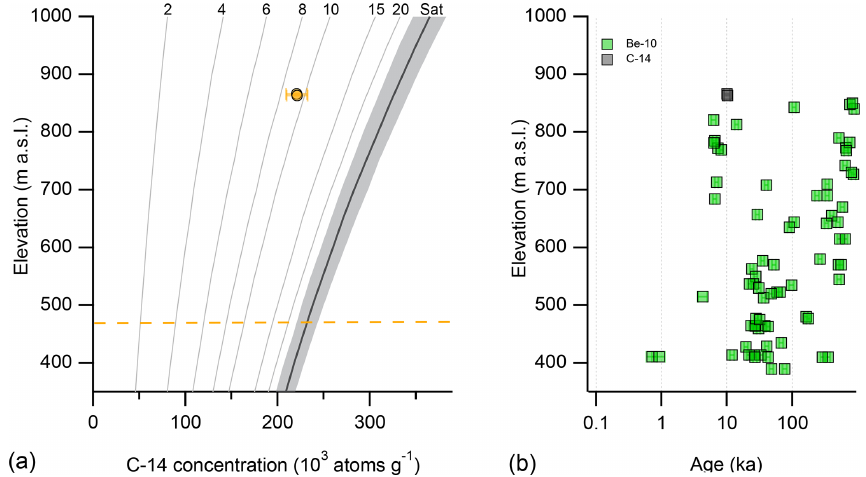
Figure 8. (a) Elevation versus in situ 14 C concentration of samples collected from the Thomas Hills. All samples are erratics. Note that both plots contain in situ 14 C data for two samples within close agreement, such that the points overlap. (b) Thomas Hills exposure ages from this study (in situ 14 C) and those of Balco et al. (2016) and Bentley et al. (2017) ( 10